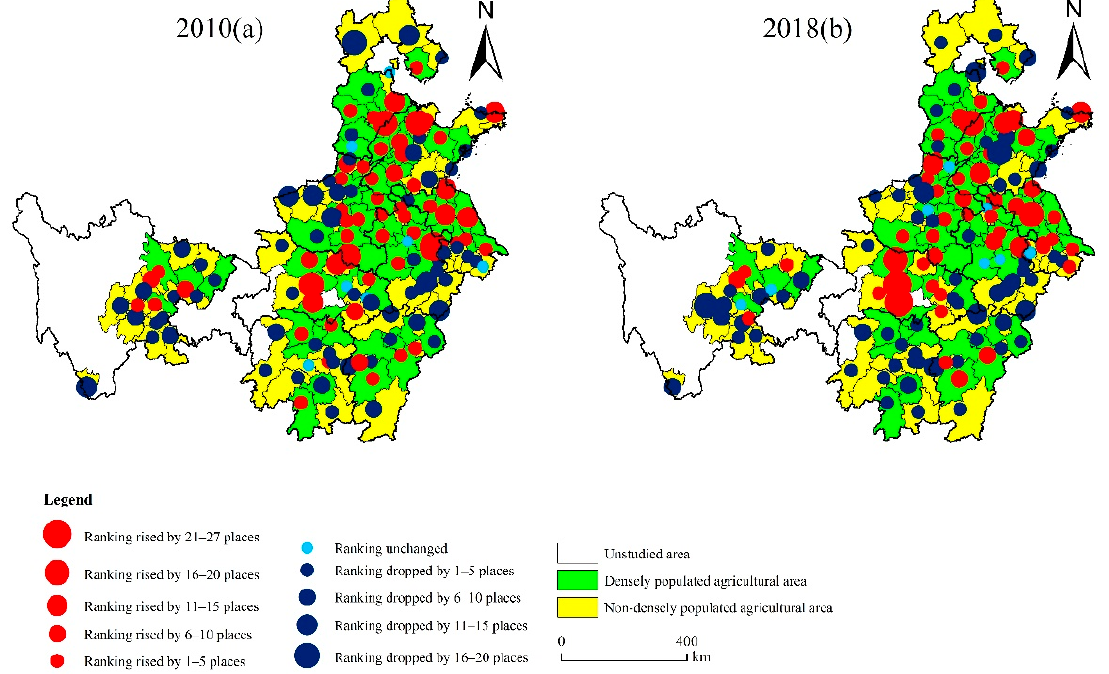
Figure 5. Changes in urbanization quality rankings after adding agricultural development to the evaluation indicator system.